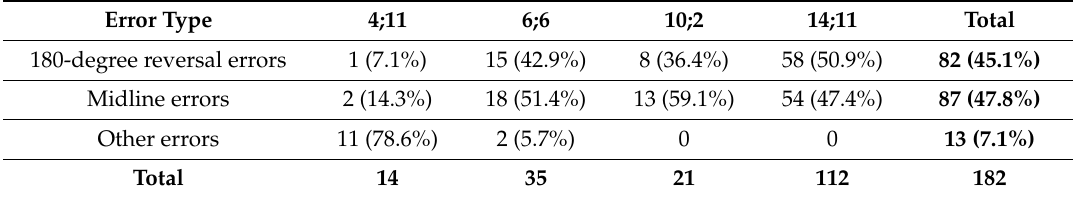
Table 4. Palm orientation errors by type at each